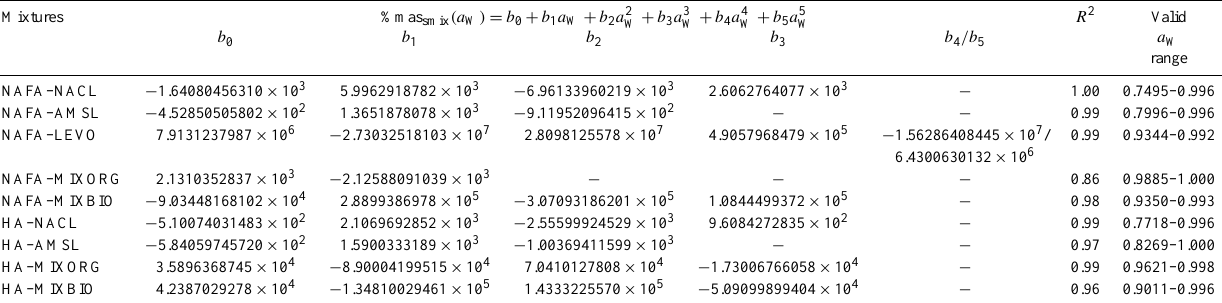
Table 2. Water activity parameterization of data at 25 ◦ C, presented as mass percent (%mass mix ) versus water activity ( a W ). Every coefficient ( b i ) reported in the parameterization, aong with all its decimals, should be used in calculations.